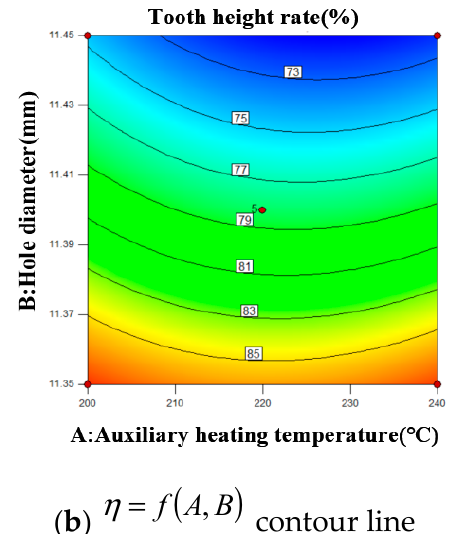
Figure 4. The correlation between the actual and predicted